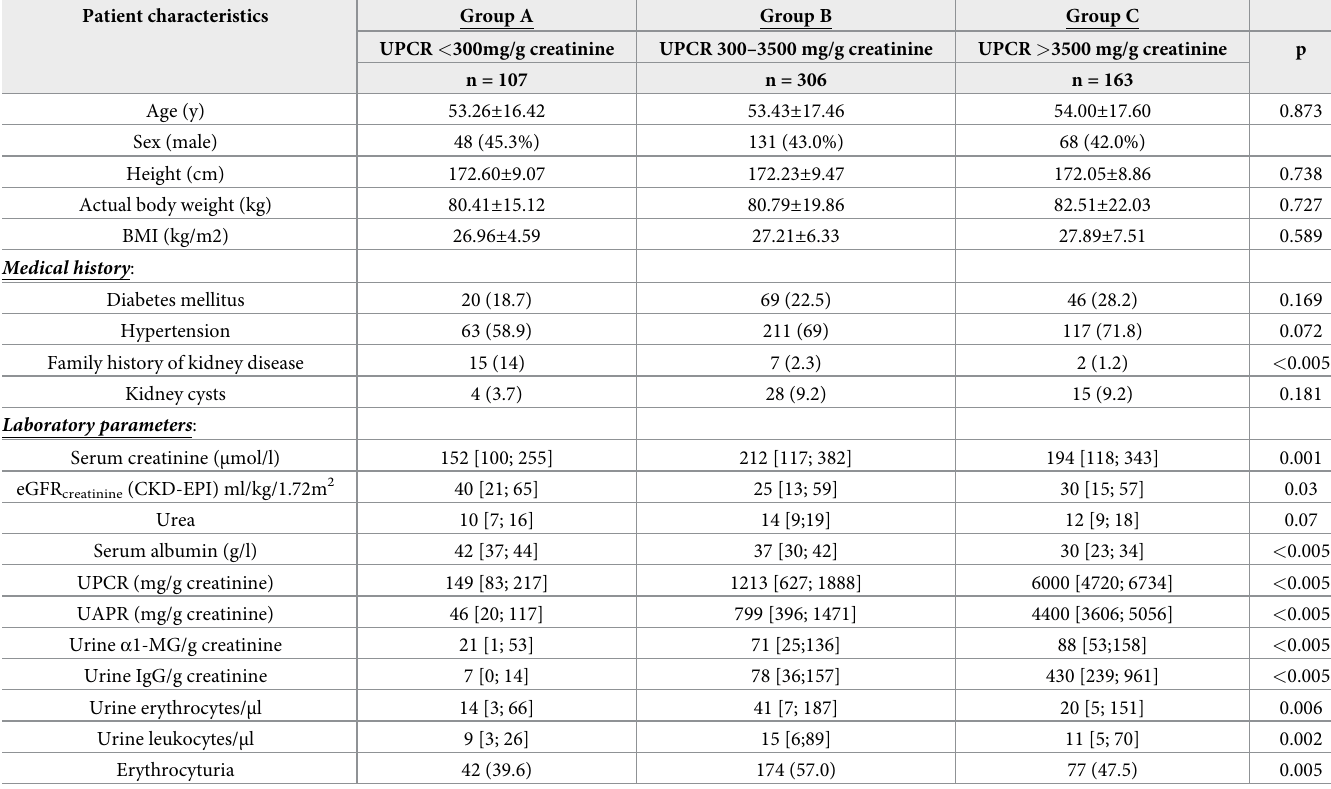
Table 1. Patient baseline characteristics at native kidney biopsy. Patient